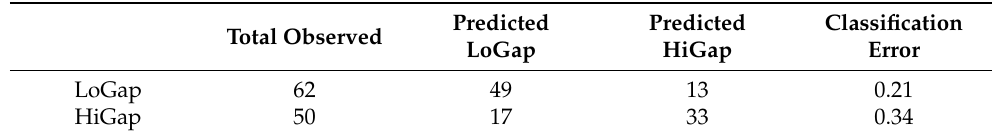
Table 4. Confusion matrix (values correctly and incorrectly predicted for field observations) for the Random Forests model to predict Ladder Fuel Hazard Assessment Class (LFHAC); Malheur National Forest near John Day, OR, USA. Predicted Predicted Classification Total Observed LoGap HiGap Error LoGap 62 0.34